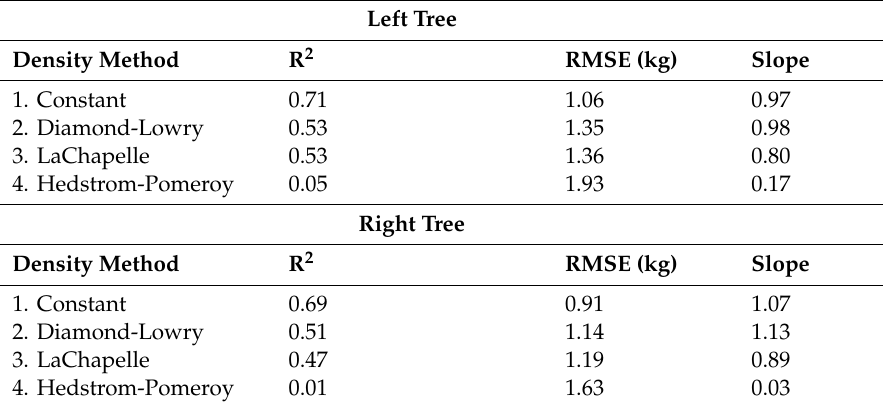
Table 2. Simple linear regression results comparing predicted and measured snow interception mass for each of the density estimation Equations (1)–(4) [1,31,32]. Data spans winters 2017–2018. The snow density constant produced the best model fit and lowest error for both